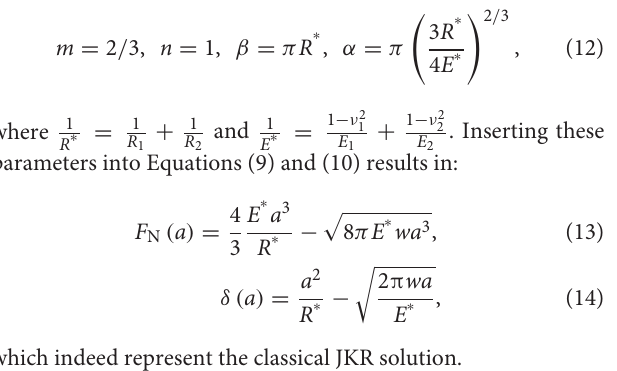
denoted by a . By a comparison with the predefined